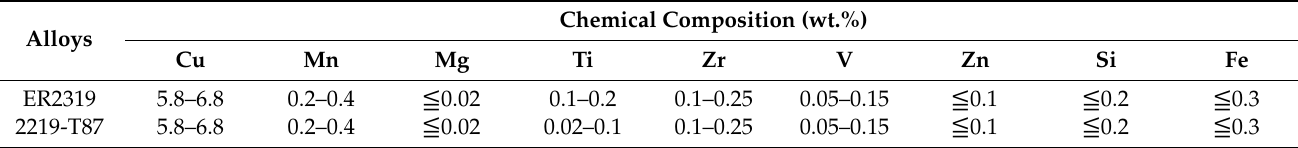
Table 1. A Fronius CMT Advanced 4000 R was used as the heat source in this study. As